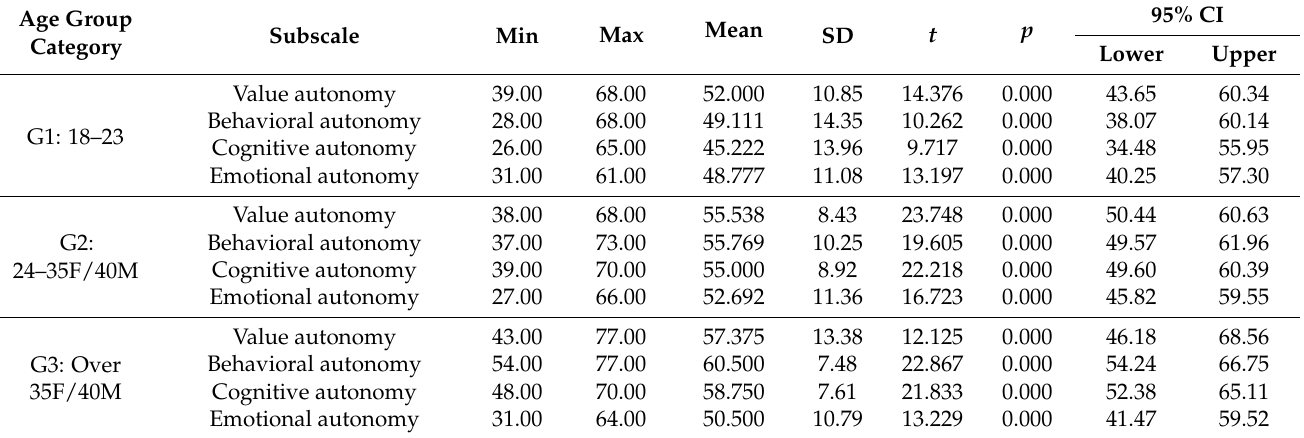
Table 8. Descriptive statistics of the results of the Personal Autonomy Questionnaire (PAQ) subscales.